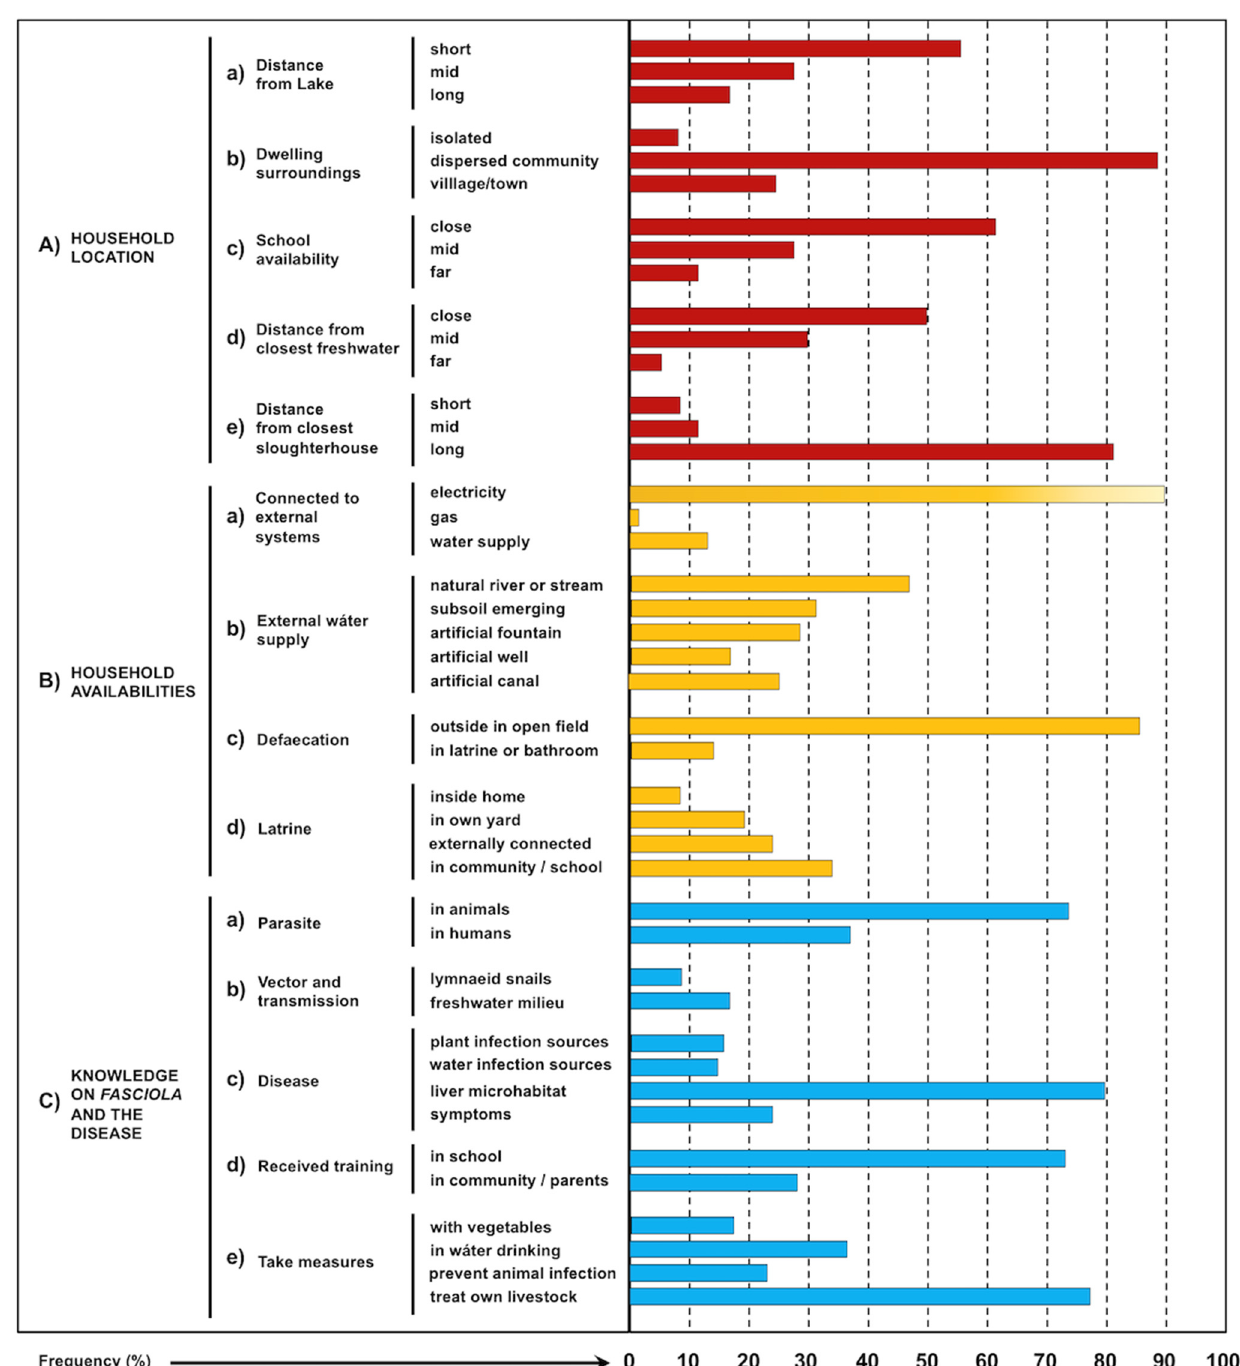
Figure 7. Results (%) of the quantitative analyses of the characteristics of 23 Aymara communities presenting human infection by Fasciola hepatica , covering all zones of the human fascioliasis hyperendemic area in the Northern Bolivian Altiplano with transmission foci in each endemic inter-hilly flat corridor or transect, including information obtained in the ethnographic fieldwork, during all seasons and throughout a very long period of 35 years, about aspects linked to fascioliasis transmission and human infection: ( A ) household location; ( B ) household availabilities (degraded colour in “access to electricity” refers to pronounced improvement along the last three decades up to the present 90%); ( C ) knowledge of the inhabitants on Fasciola , the infection by this parasite, and the disease it causes.